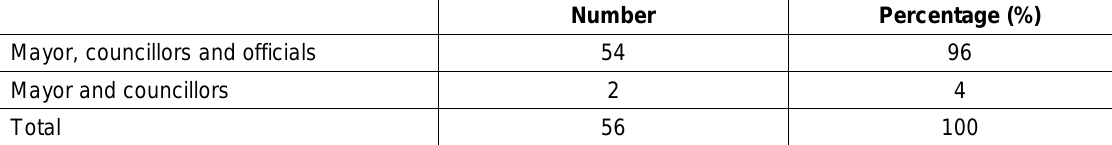
Table 5: Views on who participates in decision-making (general public) Mayor and